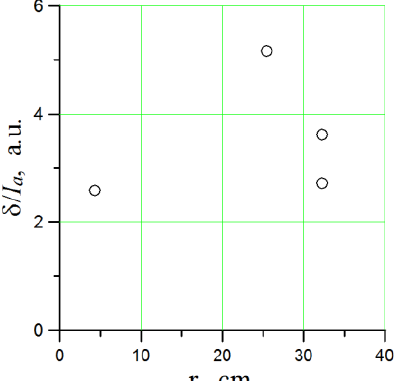
Fig. 3. The ratio at different distances between the axis of symmetry of the streamer zone and the axis of the microwave